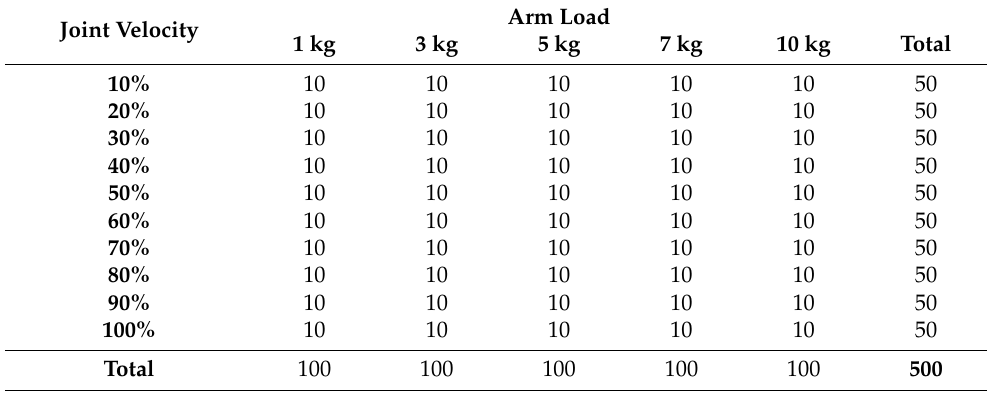
Table 2. Number of measuring the velocity and noise of the robotic arm.